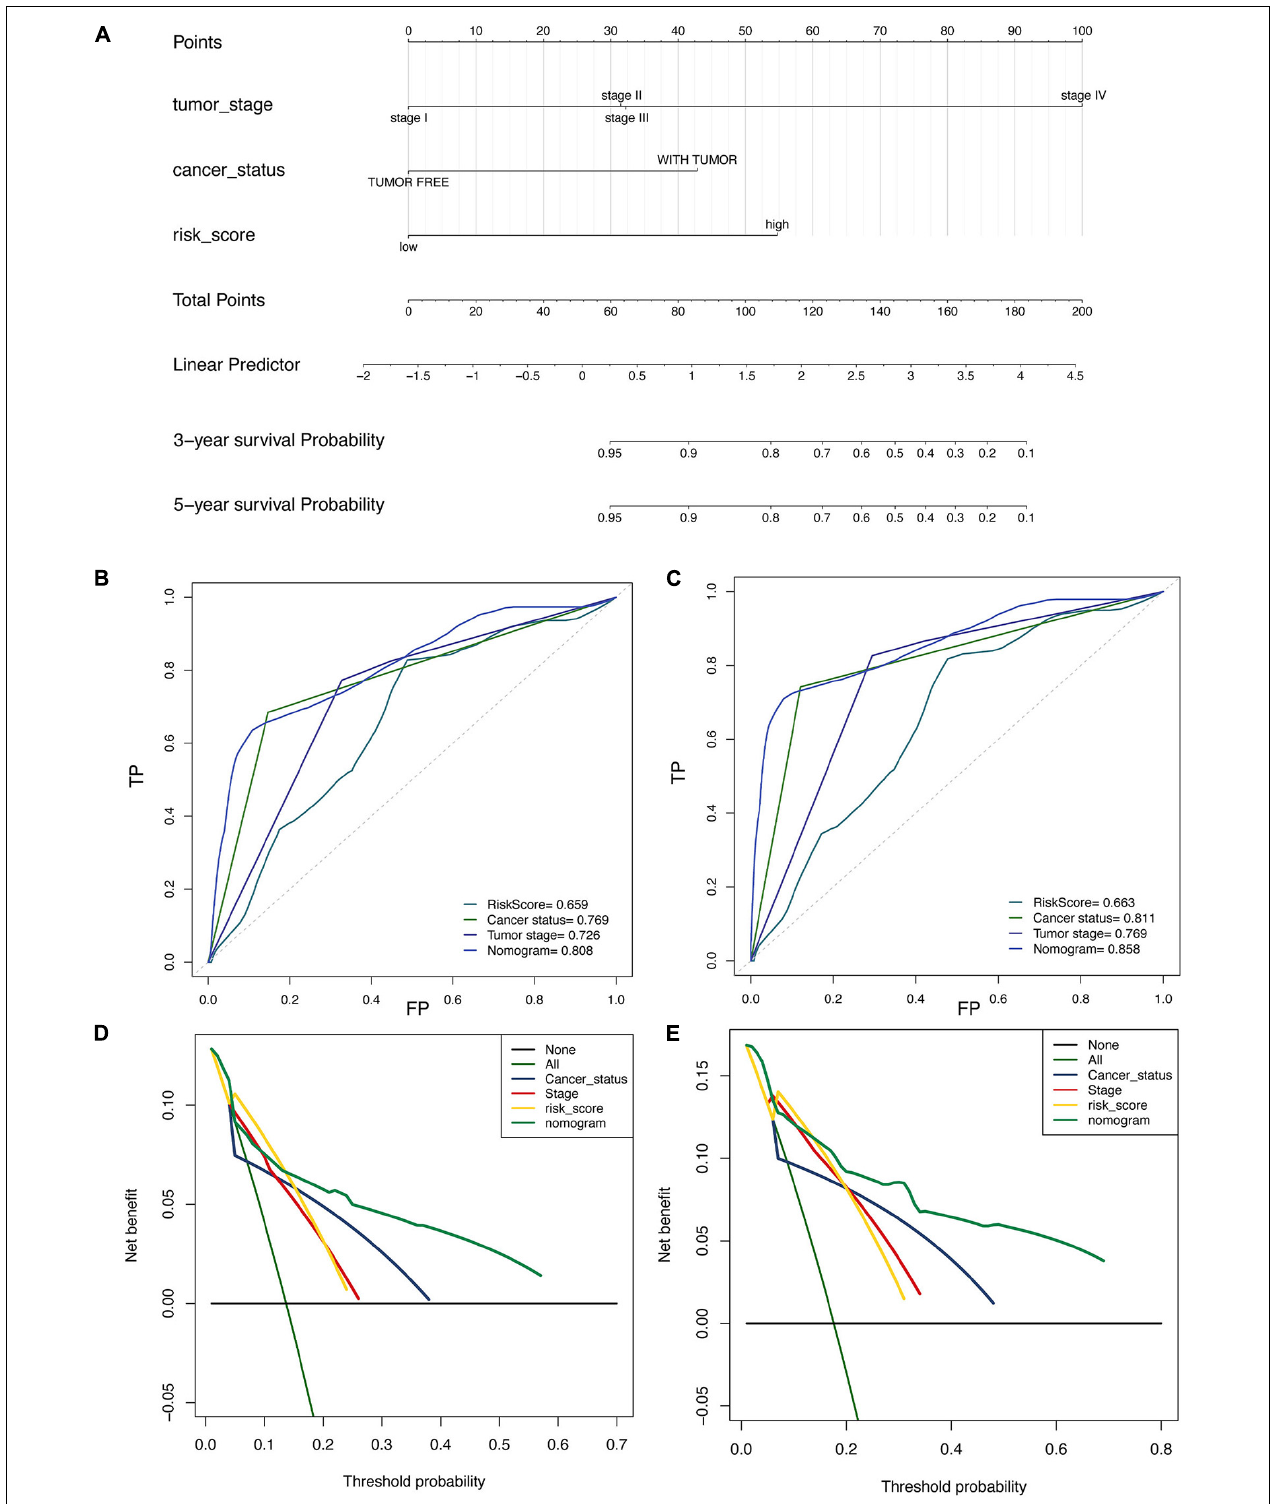
FIGURE 5 | Construction and validation of nomogram in patients with gynecological malignant tumors. (A) Nomogram integrated risk factors such as risk signature, age and stage. (B,C) The ROC curve for 3-year (B) and the 5-year (C) . (D,E) Decision curve analysis for 3-year (D) and the 5-year (E) .